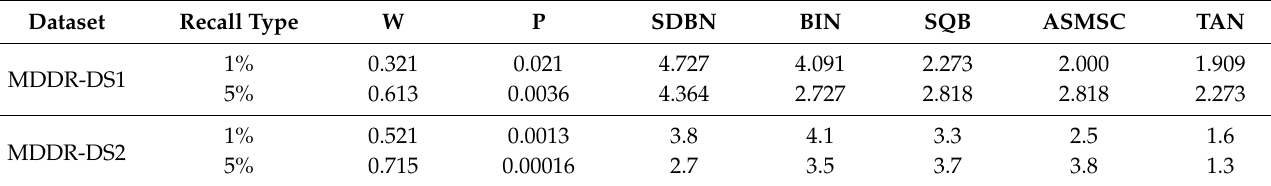
Table 10. The results of Kendall W test for DS1 and DS2 datasets.